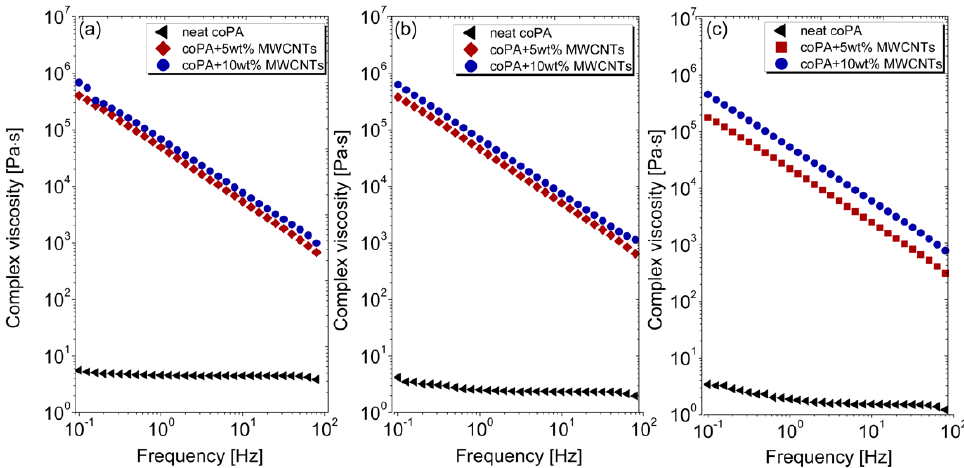
Figure 3. Variation in a complex viscosity as a function of frequency of unfilled and filled coPA measured at: ( a ) 180 ° C; ( b ) 200 ° C and ( c ) 220 ° C. measured at: ( a ) 180 ◦ C; ( b ) 200 ◦ C and ( c ) 220 ◦